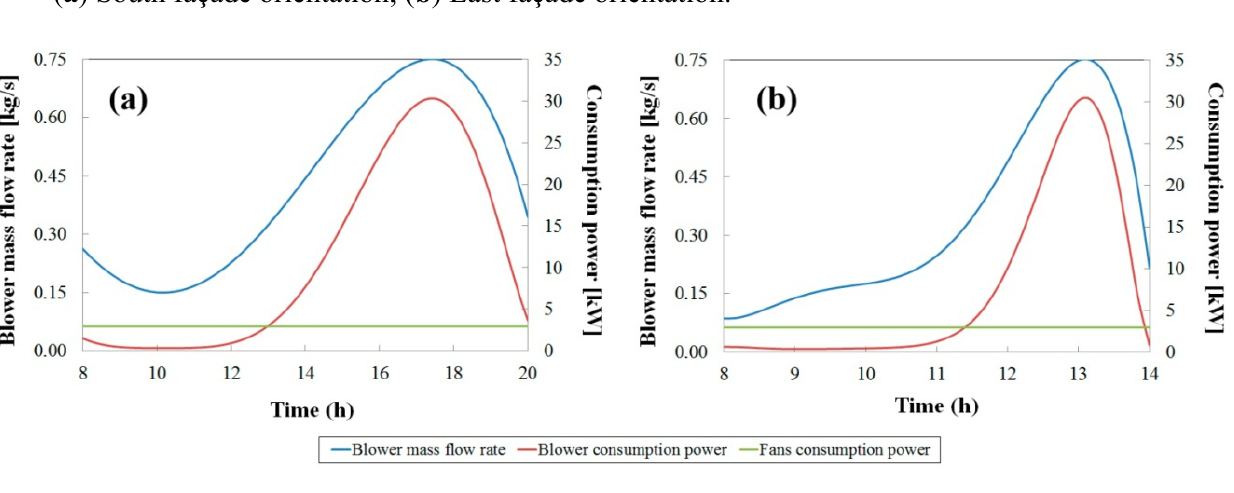
Figure 6. Mass flow rate and energy consumption of both ventilation systems compared.